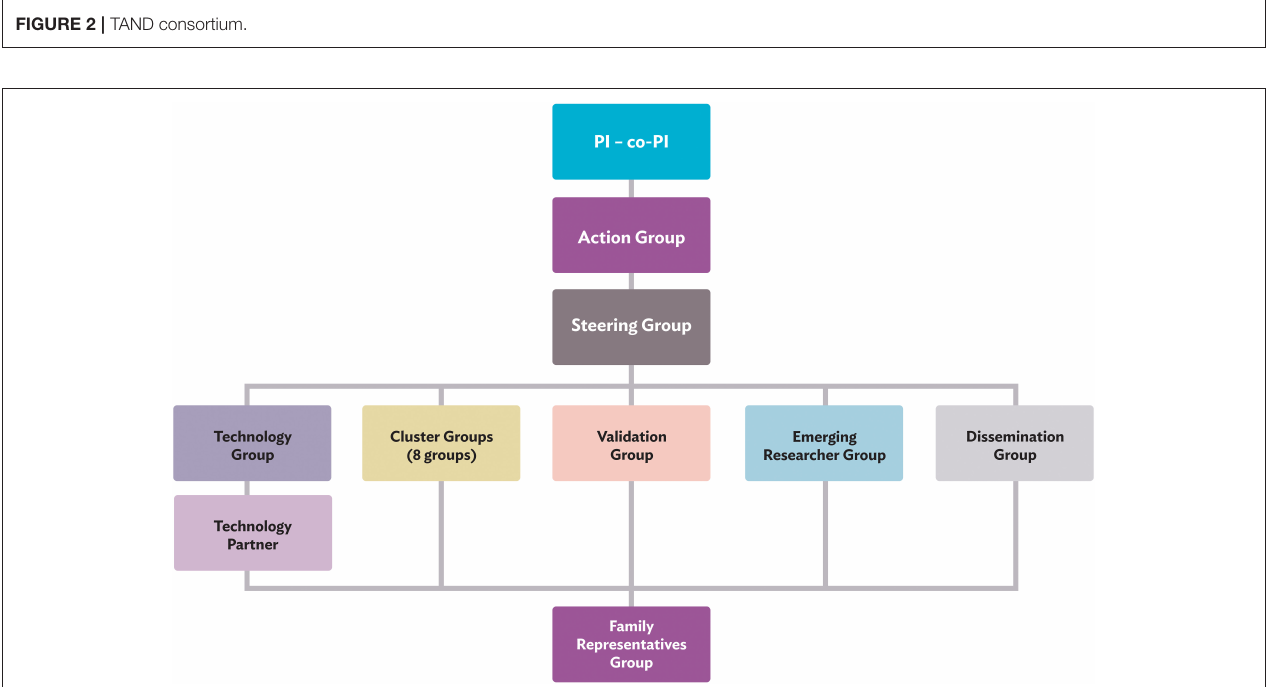
‘TSC Story’ (information about the TSC diagnosis), complete a self-report, quantified version of the TAND Checklist—the TAND-SQ (to identify and quantify the severity of